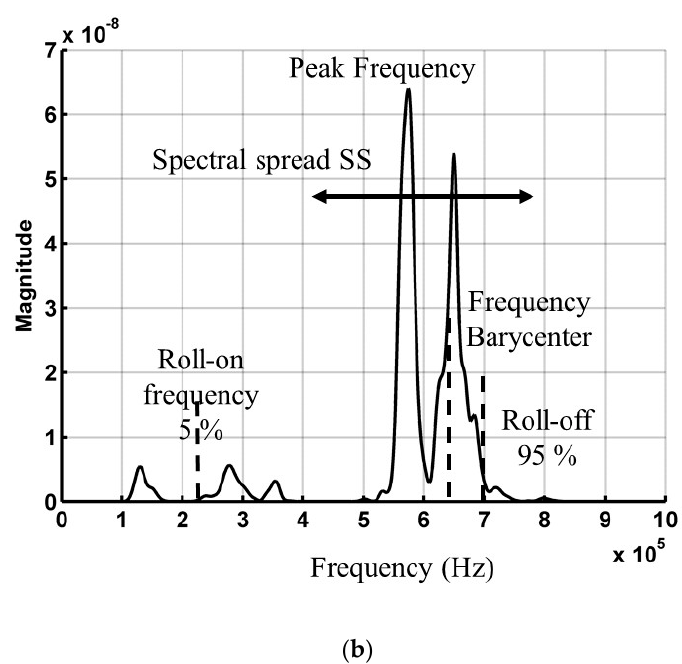
Figure 7. A typical experimental acoustic emission signals and several descriptors in the time ( a ) and frequency ( b )